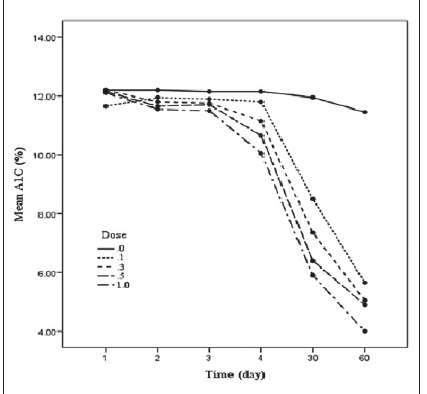
Figure 1. HbA1c incubated with 5 mM glucose and different doses of Citrullus colocynthis extract (0, 0.1, 0.3, 0.5, and 1 g/dL) in days 1, 2, 3, 4, 30, and 60 Dose 0 or positive control: HbA1c incubated with 5 mM glucose in days 1, 2, 3, 4, 30, and 60 Dose 0.1: HbA1c incubated with 5 mM glucose + Citrullus colocynthis extract 0.1 g/dL in days 1,